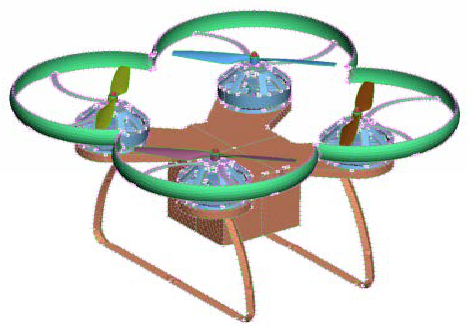
Figure 9. Finite element model of four rotor aircraft.